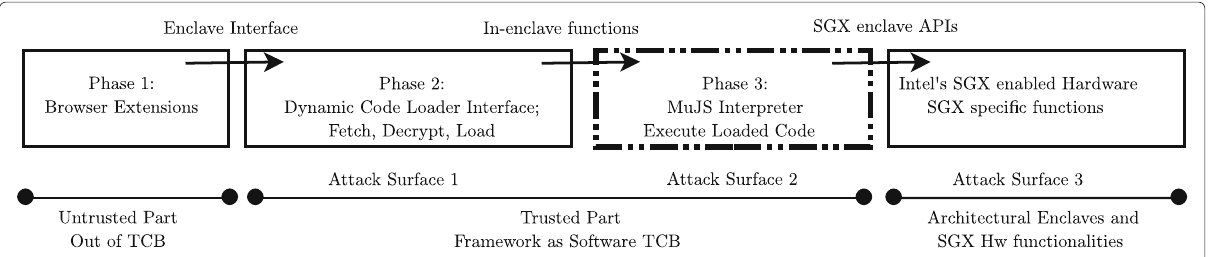
Fig. 4 Attack surfaces on TrustJS and SecureJS in two phases (2 and 3). Phase 1: Browser extension receives the code. Phase 2: Dynamic code loaders prepare the code blob. Phase 3: Interpreter executes the code. The confidential code may leak due to attacks placed on surface 1 and 2, targeting the weakly developed